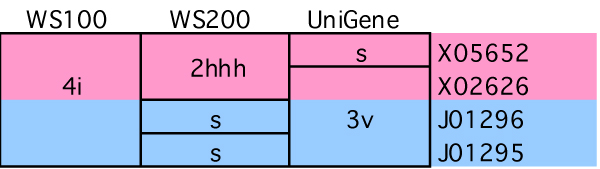
Cluster 4i. Distribution of the four mRNA sequences of WS100 Cluster 4i. Shaded colors represent mRNA sequences from the same gene as determined by alignment analysis and literature review.